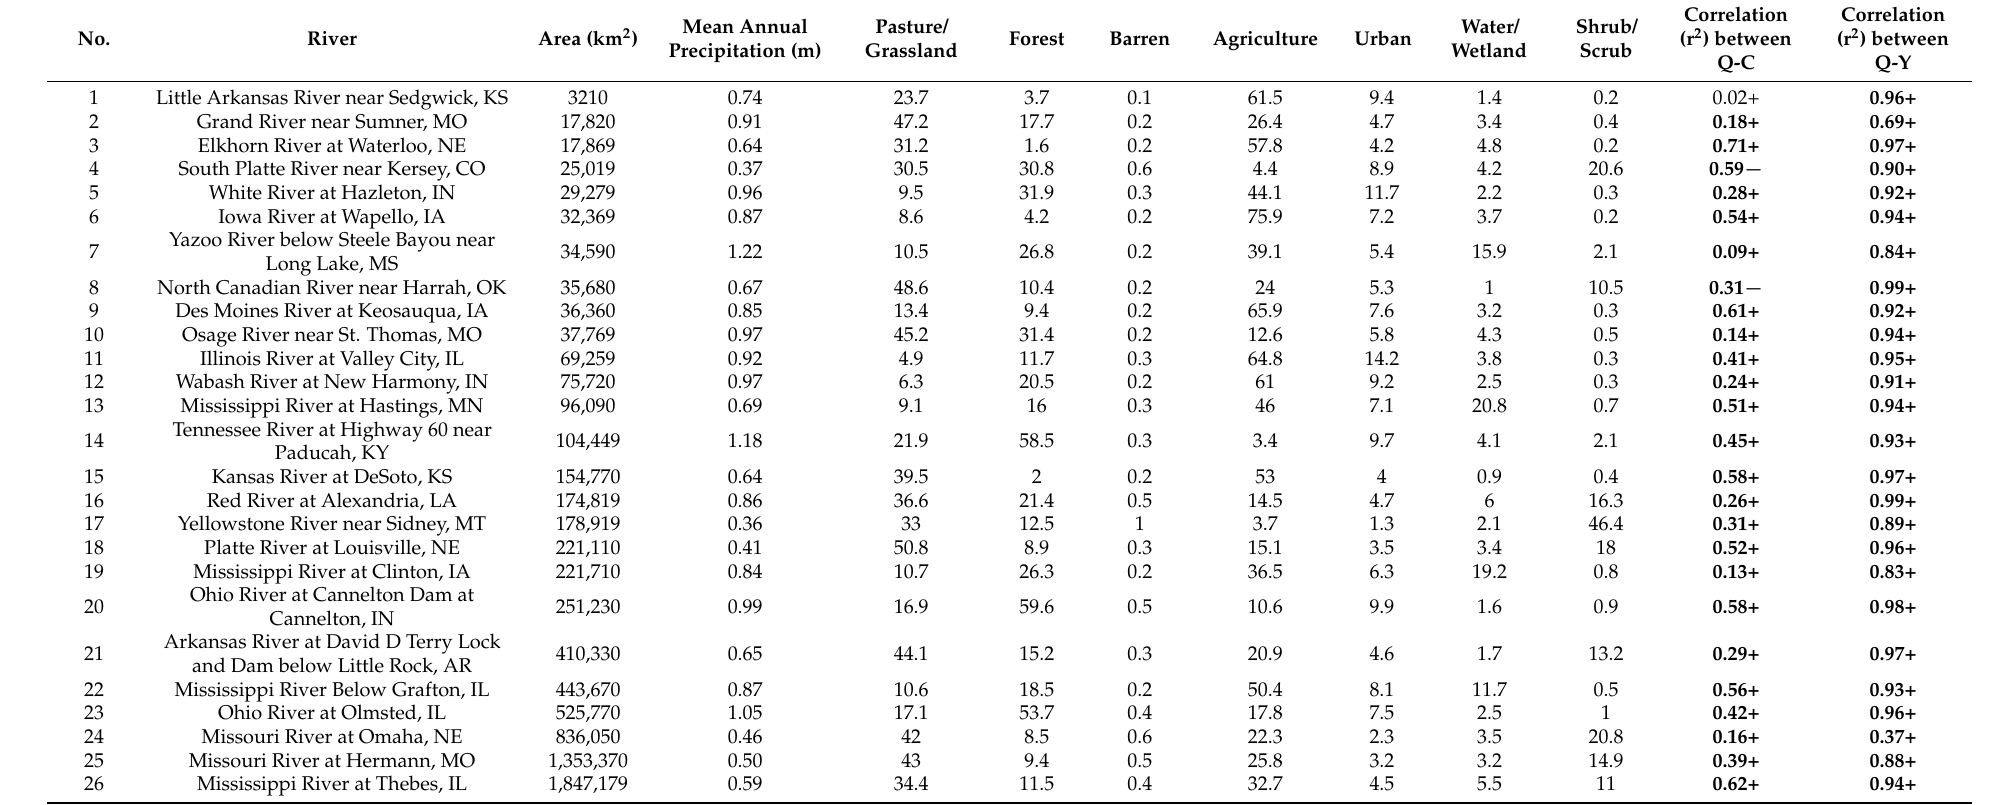
Table 2. Study rivers, catchment area (km 2 ), precipitation (mm), percentage of land cover (%), and the correlations (r 2 ) of discharge level (L min − 1 ) with both TN concentrations (mg L − 1 ) and TN yields (mg m − 2 min − 1